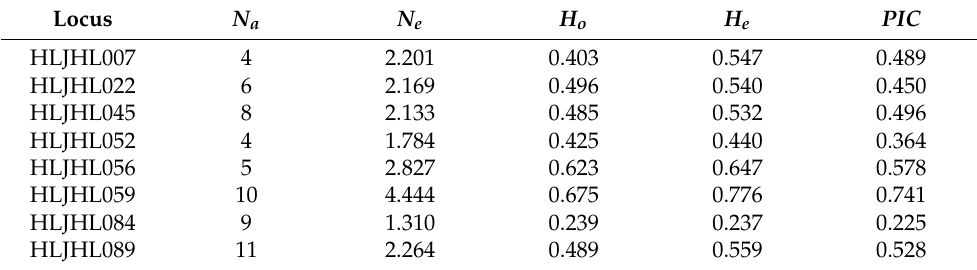
Table 3. Parameters of polymorphism described for the 29 microsatellite loci selected in the popula- tions of P. fluviatilis